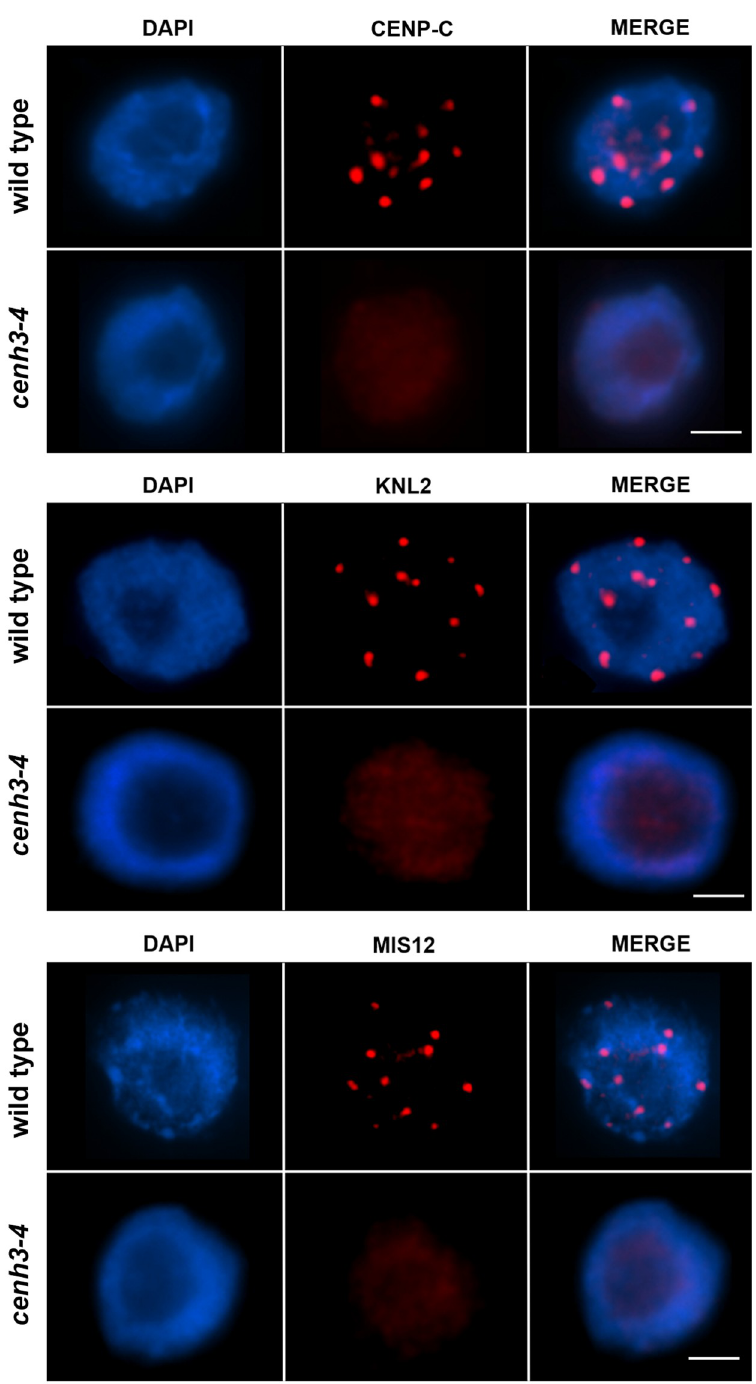
Fig 8. Immunodetection of CENP-C, KNL2 and MIS12 in root nuclei of cenh3-4 and wild type. DNA is counter- stained with DAPI (blue). Longer exposure times for cenh3-4 were applied to detect a signal. Scale bar = 5 μ m.